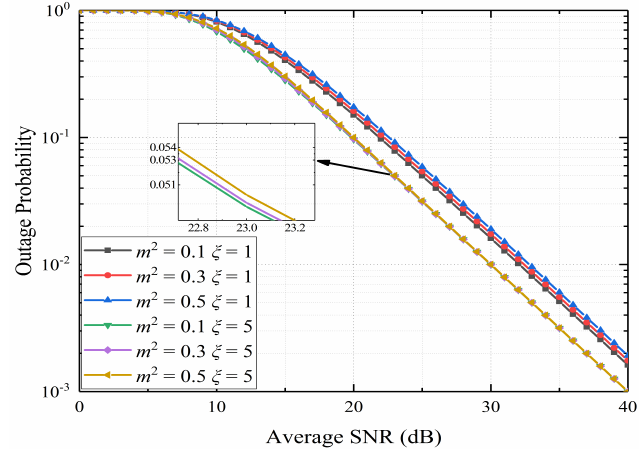
Figure 6. Outage probability against average signal-to-noise ratio (SNR) per hop for various scin- tillation intensities and different pointing error parameters. The threshold of the hybrid system is γ th = 10 dB.